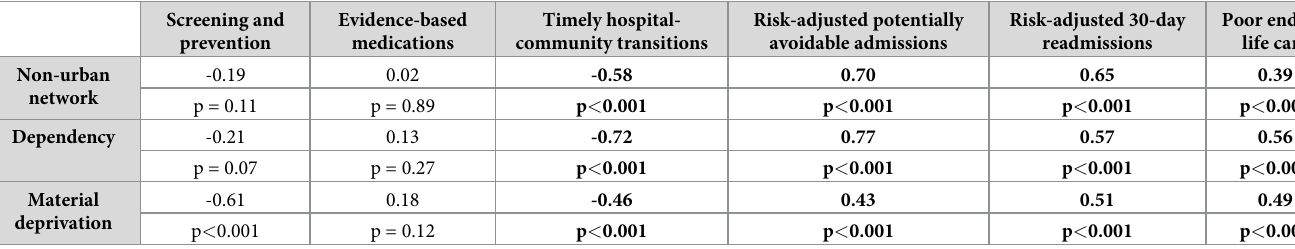
Table 4. Correlations between network characteristics and quality domain rates. Screening and